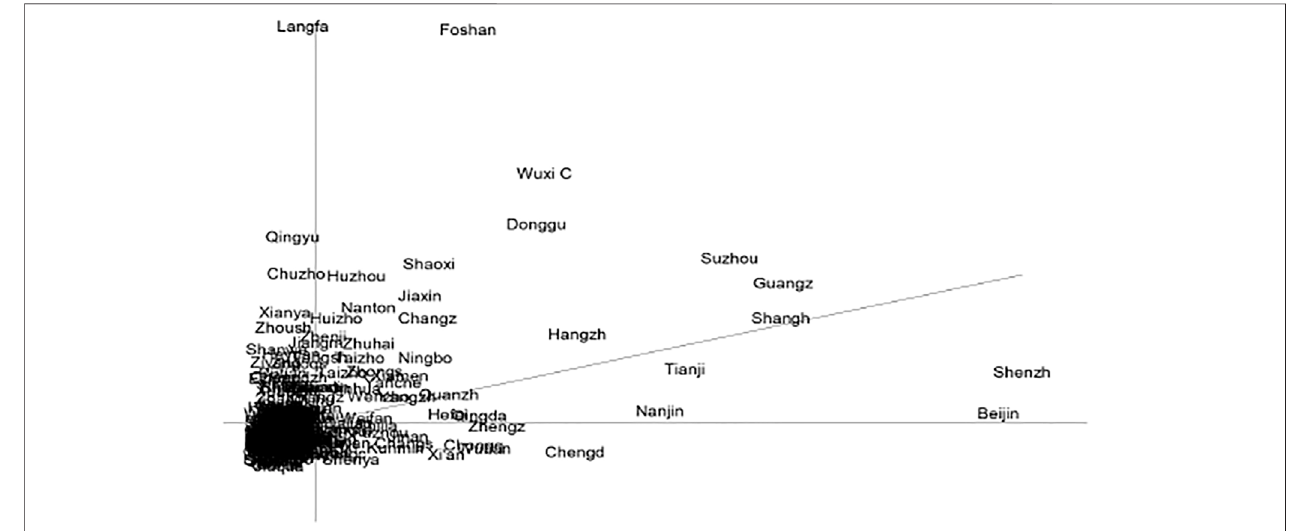
FIGURE 4 | The Moran Index of green utility model patents in